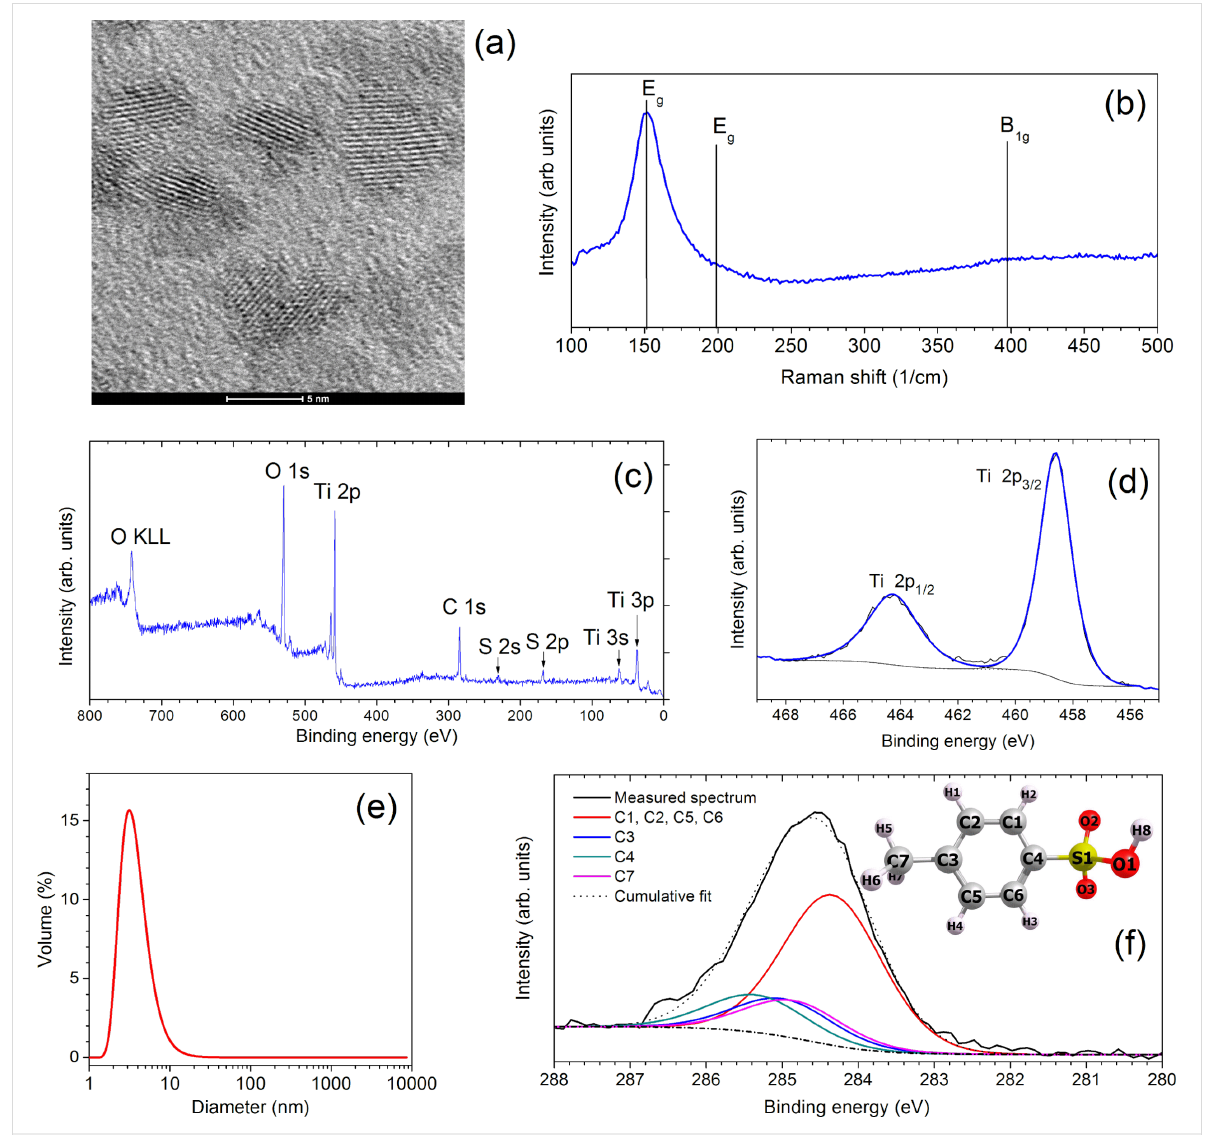
Figure 3: Characterization of the synthesized NPs and their thin films bound with PTSA. (a) TEM images of TiO 2 nanoparticles; (b) Raman spectrum of the NP-based thin film showing the existence of the anatase crystal phase (E g band at 151 cm − 1 ); (c) XPS overview spectrum demonstrating the presence of titanium, oxygen, carbon and sulfur in the NP-based thin film; (d) Ti 2p photoemission lines typical for Ti 4+ do not show the presence of reduced titanium ions (Ti 3+ ) in TiO 2 ; (e) hydrodynamic size distribution of the NPs (measured by DLS in colloidal dispersion); (f) measured XPS spec- trum of the C 1s region and calculated XPS spectra for PTSA including sub-bands. Locations of the respective atoms in the PTSA molecule are also shown (inset).